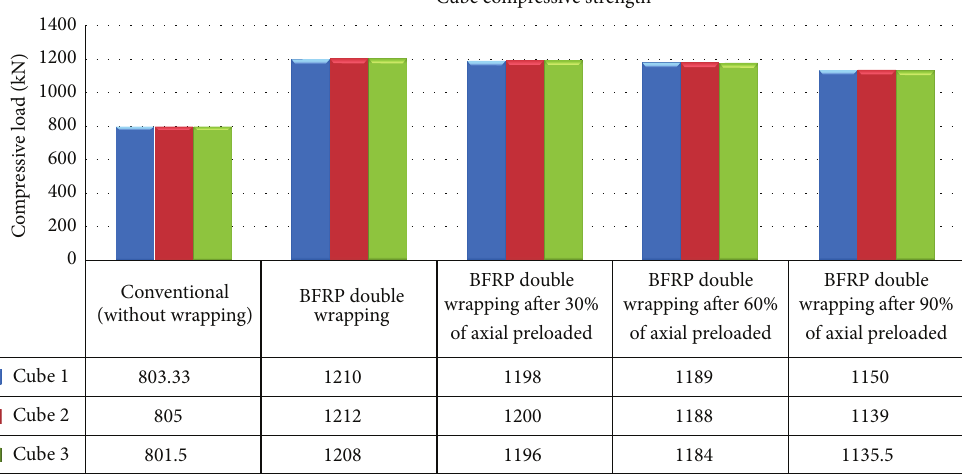
Figure 3: Conventional and BFRP retrofitted cubes performance compression load.